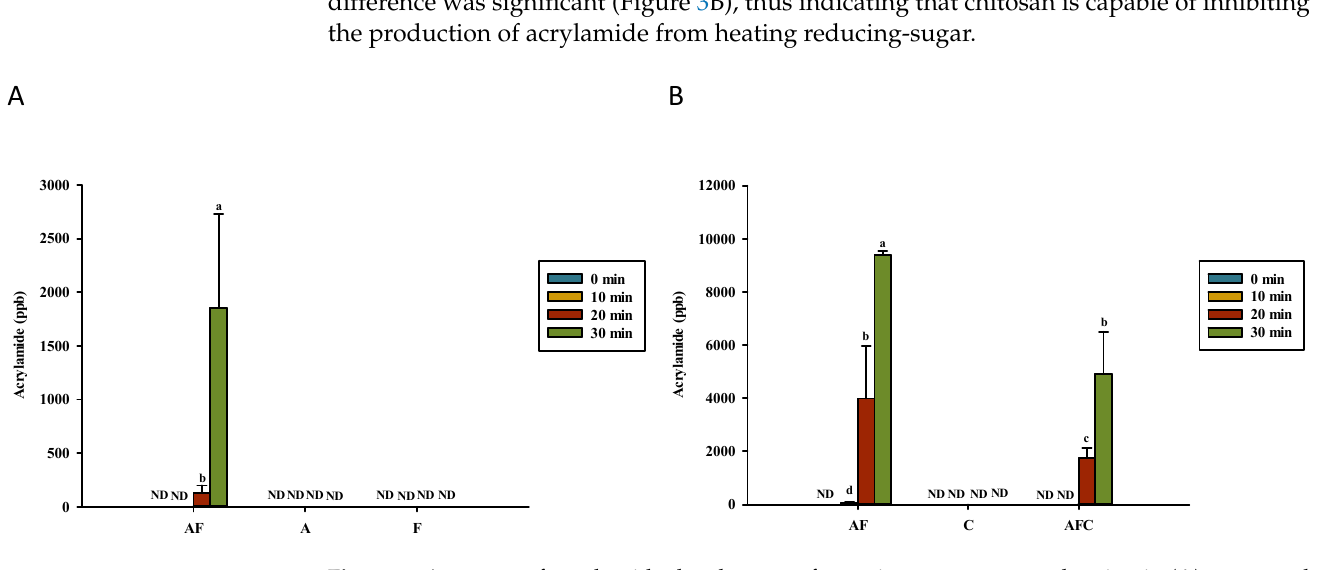
Figure 3. Amounts of acrylamide development for various groups upon heating in ( A ) water and ( B ) acetic acid. AF, asparagine and fructose; A, asparagine; F, fructose; C, chitosan; AFC, asparagine, fructose and chitosan. Data represent the means of three replicates, and error bars indicate standard deviation. Bars followed by a common letter are not significantly different according to the Dunn’s test at the 5% level of significance (ND, not detected).